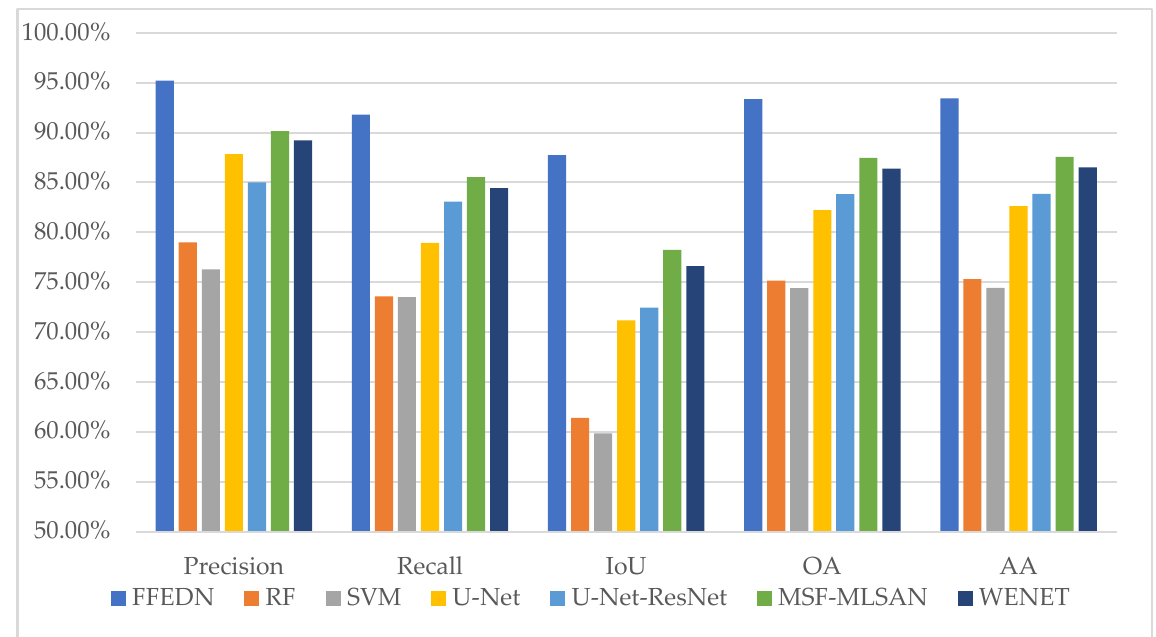
Figure 15. Visual comparison of evaluation indicators for different methods.